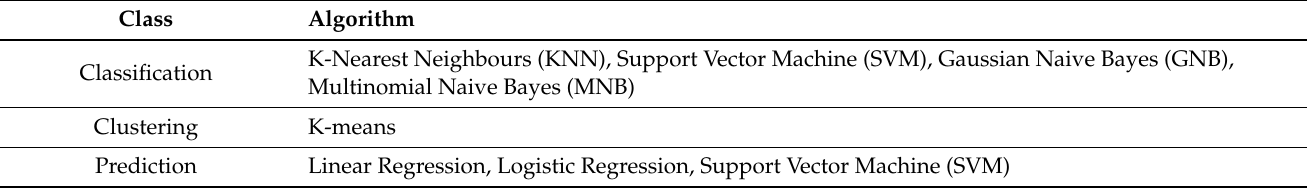
Table 3. Framework model